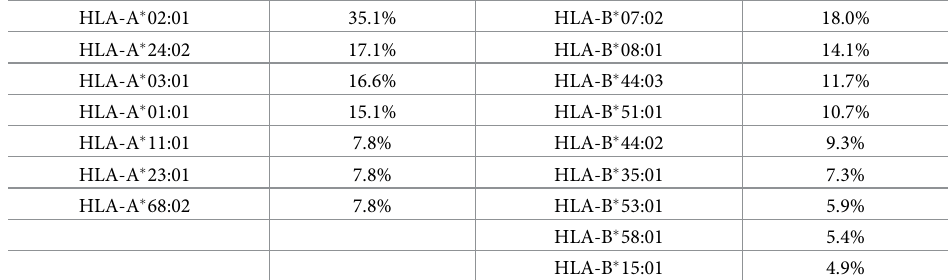
Table 1. Decreasing frequencies of the HLA alleles A and B of the Provir/Latitude 45 population